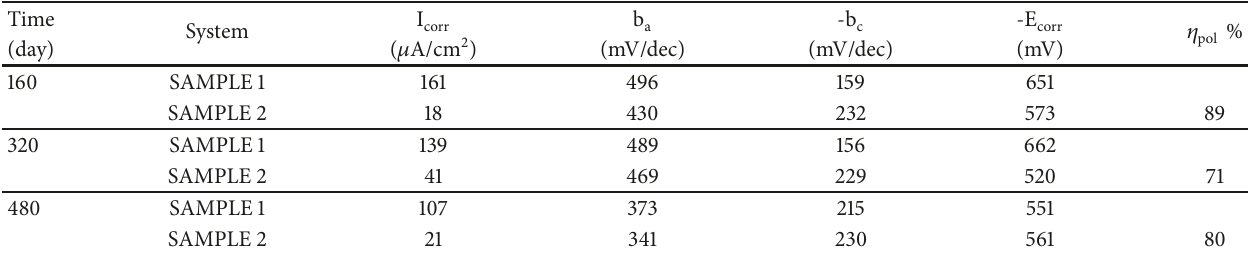
Table 1: Tafel data of steel reinforcement in concrete in the presence and absence of SLS for different